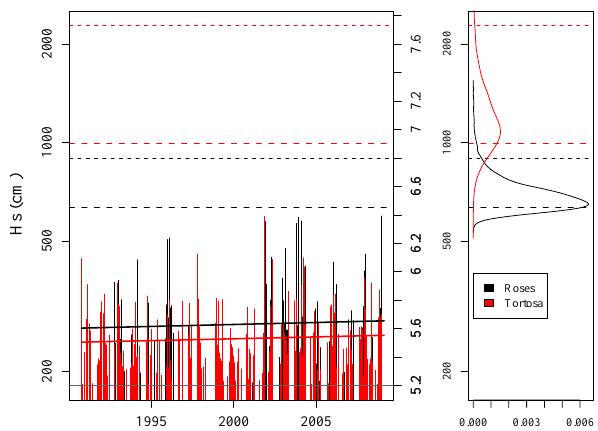
Fig. 4. Data set of events, compared with several results that share the same scale. The left panel shows the data (black: Roses, red: Tortosa), together with the time evolution of the expectation of the fitted GPD (Eq. 4, thick solid line), as derived from the maximum posterior parameter estimates (Table 1). The most likely posterior estimates (from the same Table, thick dashed line) and 95% con- fidence interval upper boundary (dashed line) for the upper bound of the excesses (Eq. 3) are also displayed. The marginal posterior density of these excess upper bound for Roses and Tortosa are dis- played separately in the right panel. Note the higher uncertainty in Tortosa than in